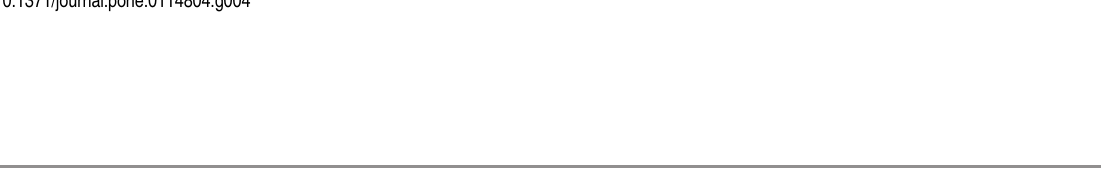
Fig. 4. IM-TORNADO pipeline workflow. Schematic of the IM-TORNADO pipeline